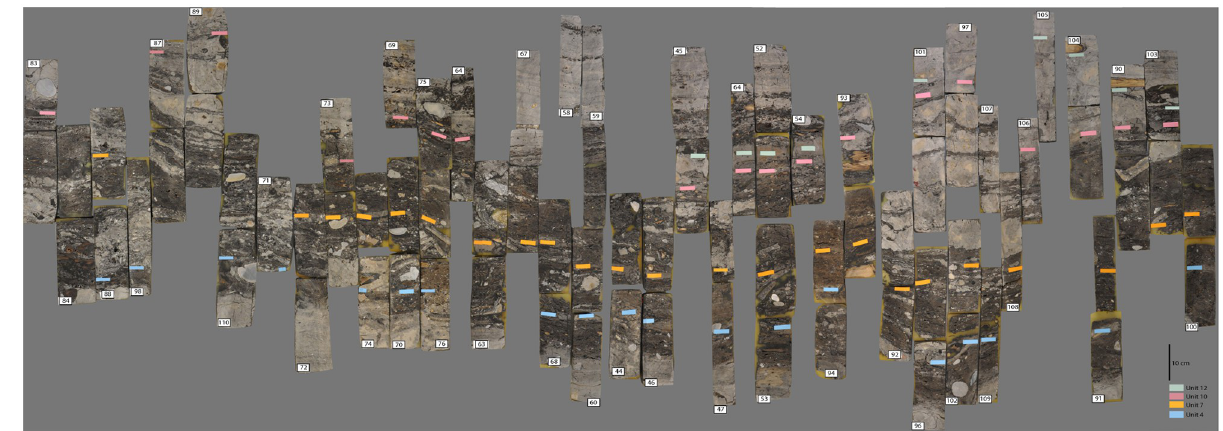
Fig 3. Projection onto a single plane of the different monolith column soil samples (polished sections). The organic micrite layers (units 4, 7, 10 and 12) serving as separators are indicated by different colours ( © K. Ismail-Meyer). See Fig 5 for the exact position of each sample.